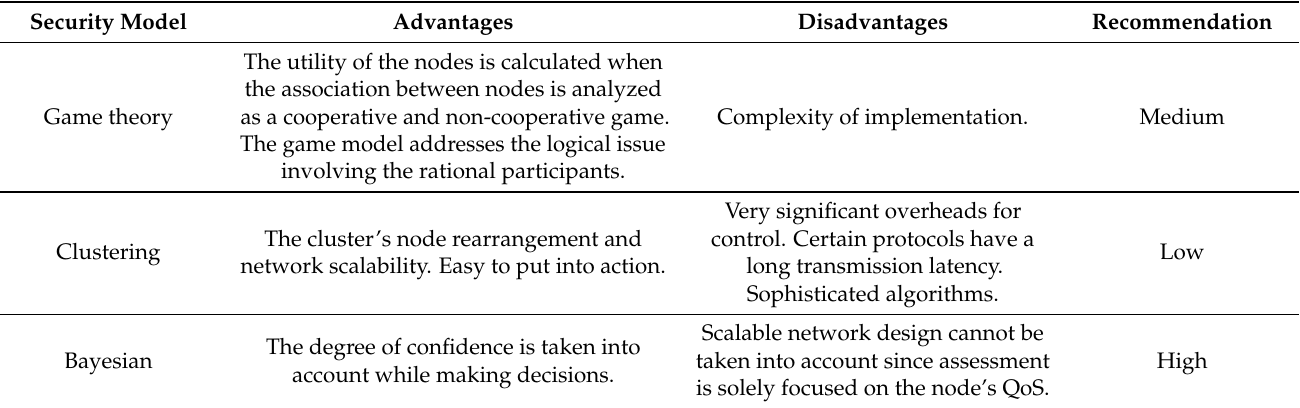
Table 3. Security Models’